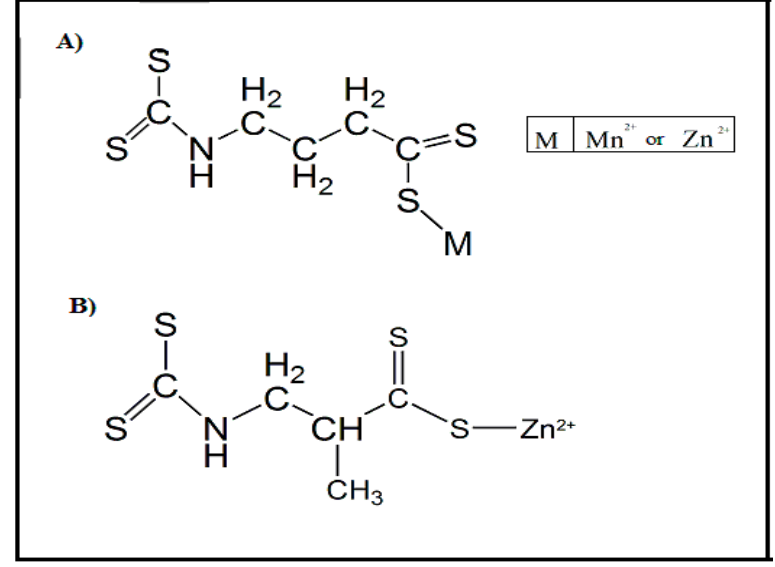
Figure 6. Synthetic dithiocarbamate derivatives bound to metal centres used as potential anti- Leishmania sp. drugs [52]. Two distinct chemical structures (A and B) that when interacting with metals (Mn 2+ or Zn 2+ ) exhibit enhanced antiparasitic activity against L. donovani parasites.